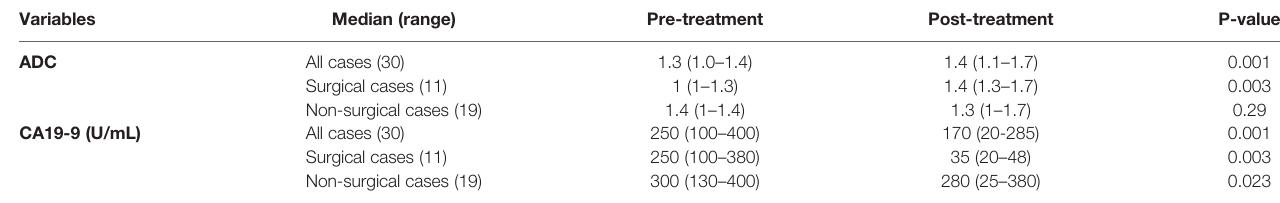
TABLE 4 | Pre- and post-neoadjuvant ADC and CA19-9 values for the study population.